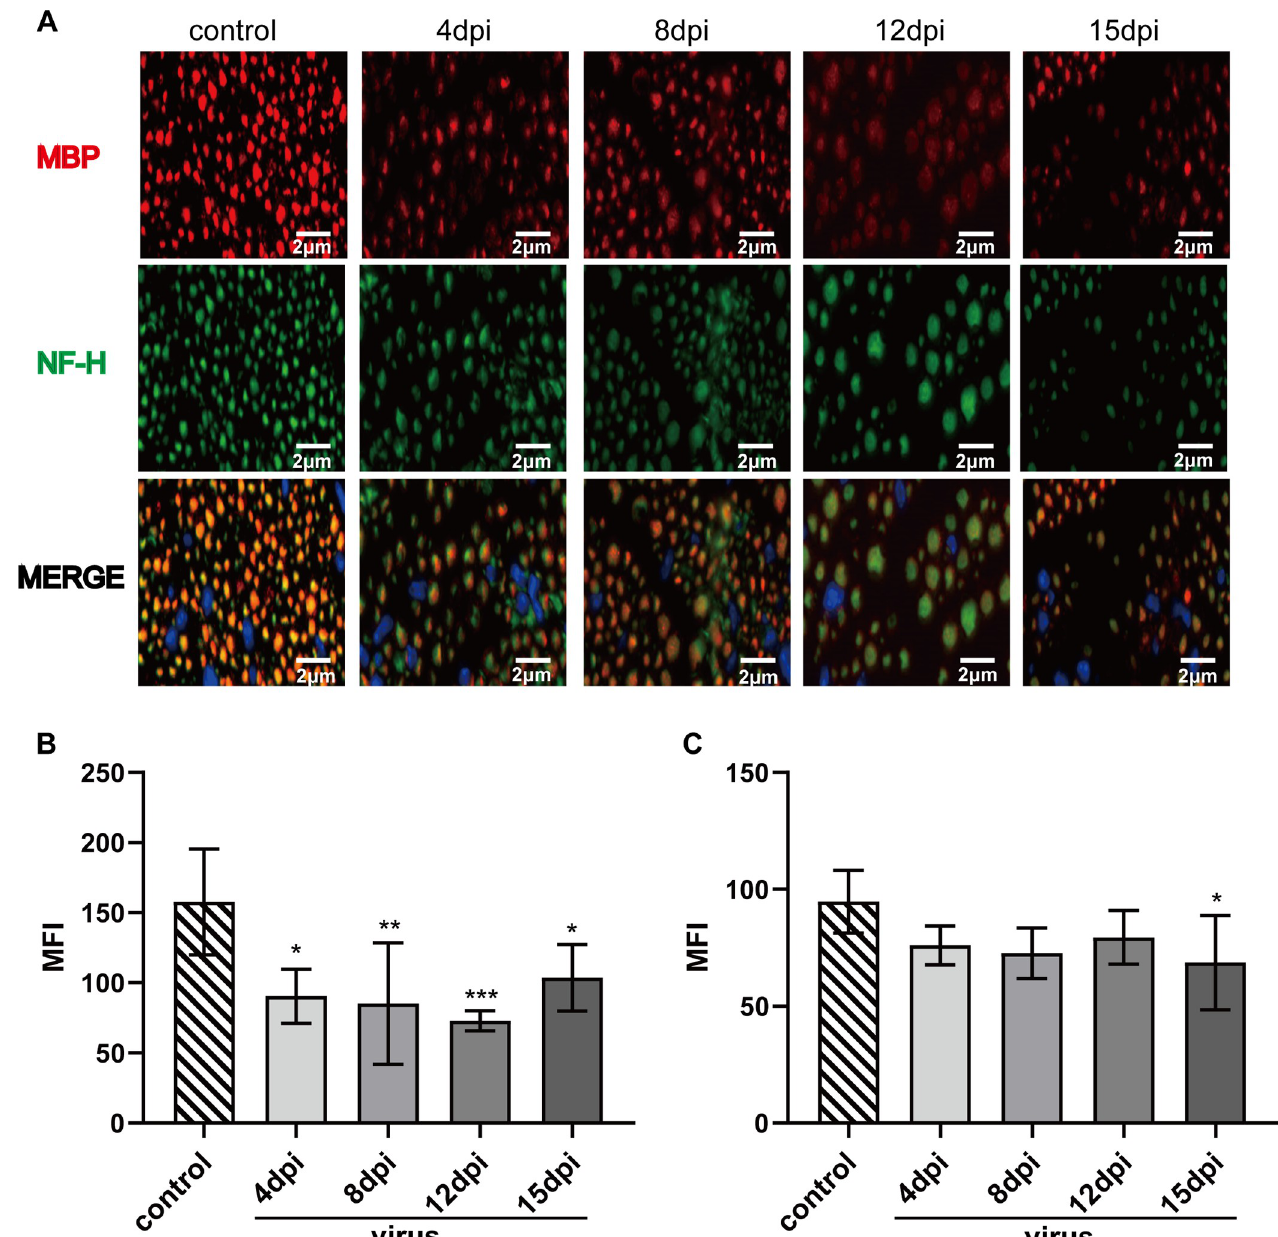
Fig 3. Immunofluorescence of mouse sciatic nerve at different time. One-way ANOVA was used. (A) The sciatic nerve tissue was double stained with MBP + NF-H and labeled with fluorescence. MBP was labeled in red and NF-H in green. Nuclei are stained DAPI (blue); (B) MFI of MBP ( �� P = 0.0015); (C) MFI of NF-H (P =